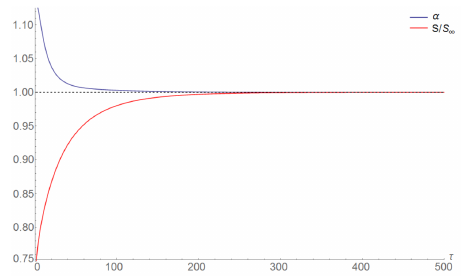
Figure 7. .Evolution of the normalized entropy and anisotropy